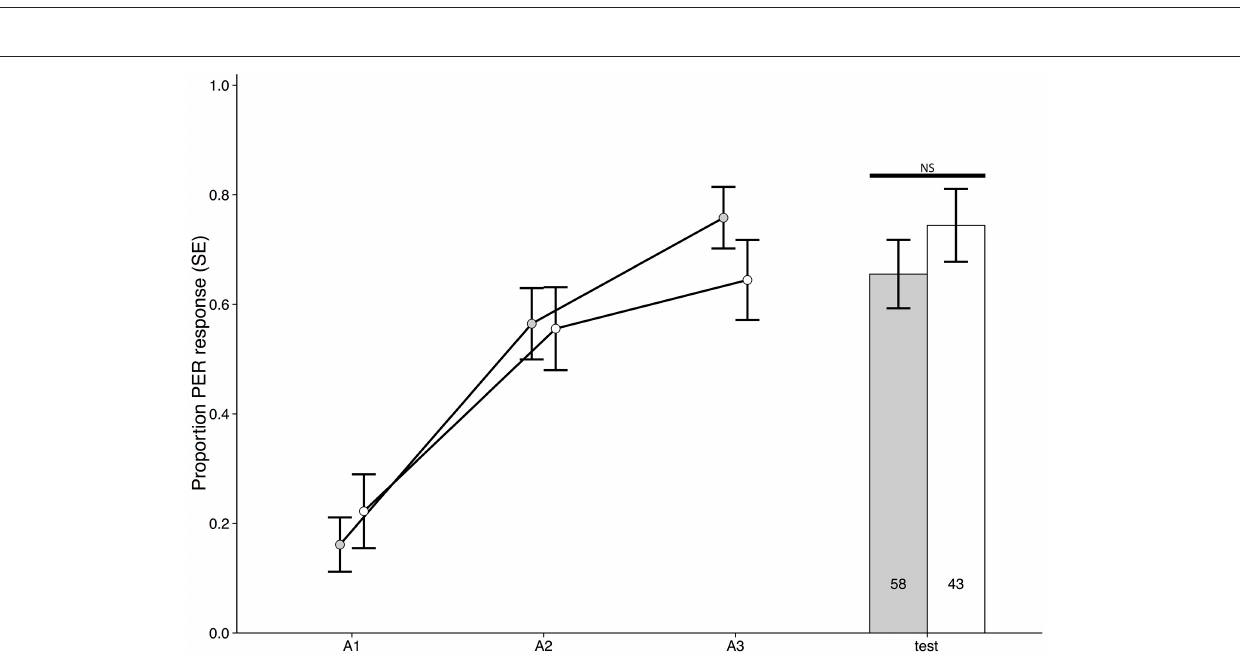
FIGURE 4 | Experiment 5: acquisition curve and test results for bees trained in a differential conditioning PER paradigm and treated with cocaine 1h after acquisition training, but tested 5h after training ( χ 2 = 0.5489, p = 0.4588, n = 101). Responses shown for the odor paired with sucrose reward, see Figure S2 for responses of the odor paired with